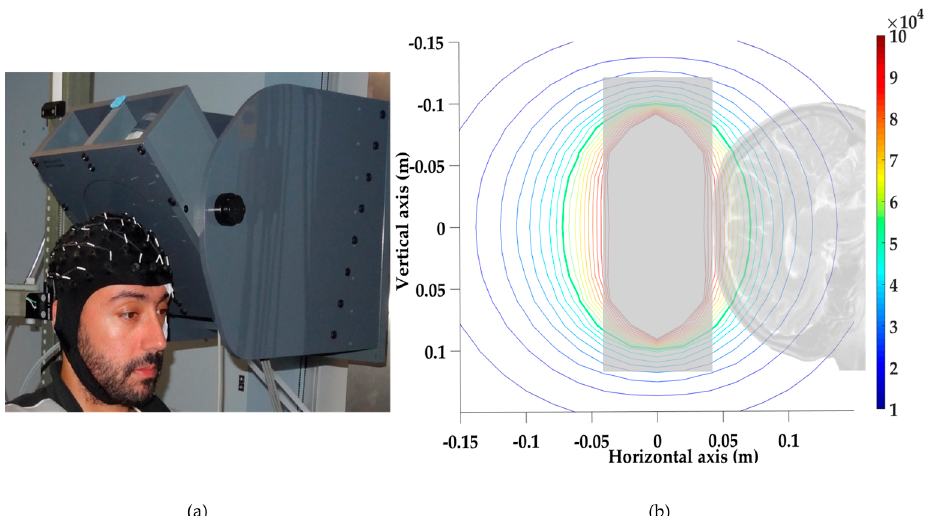
Figure 1. ( a ) Coil (encased in plastic) positioned to expose the motor cortex of a tested participant (centered on the EEG electrode, C3). ( b ) Scaled representation of a sagittal slice of human head superimposed with the field distribution, calculated using the Biot and Savart Law (10% contour lines are 5 mT rms in this case). The vertical transparent grey bar represents the coil dimensions. Brain cortical layers are exposed to a non-homogeneous 60 Hz MF calibrated to deliver 50 mT rms at 3 cm from the surface of the coil (thicker green contour line on the graph, the calculation was confirmed by a direct MF measurement, single axis MF Hall transducer, Senis™ 0YA05F-C.2T2K5J probe, Senis, Baar, Switzerland) ± 10 mT rms .